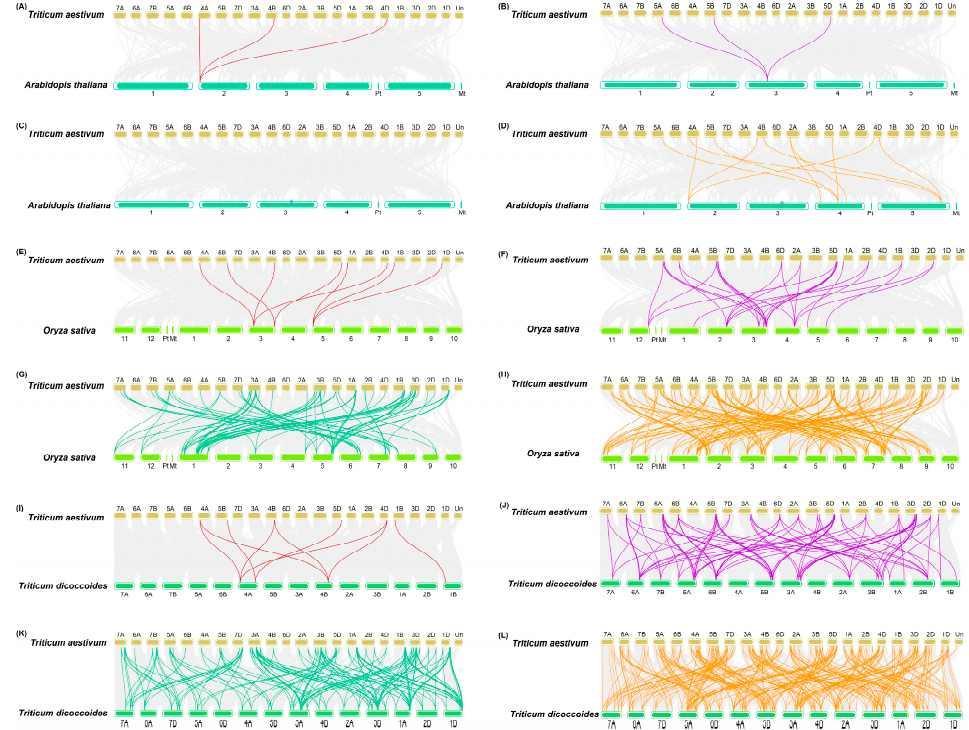
Figure 3. Genome-wide syntenic relationship of TaZFP s orthologous with three representative plants’ viz., ( A – D ) A. thaliana , ( E – H ) O. Sativa, and ( I – L ) T. dicoccoides . The grey line in the background indicates the syntenic region of T. aestivum and other plant genomes. The other coloured lines indicate different gene pairs, the red line indicates the co-linear TaC2H2 gene pair, the purple represents TaC3HC4, the green represents TaCCCH, and the orange represents TaPHD.